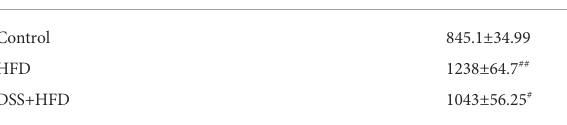
TABLE 1 Animal characteristics and metabolic fi